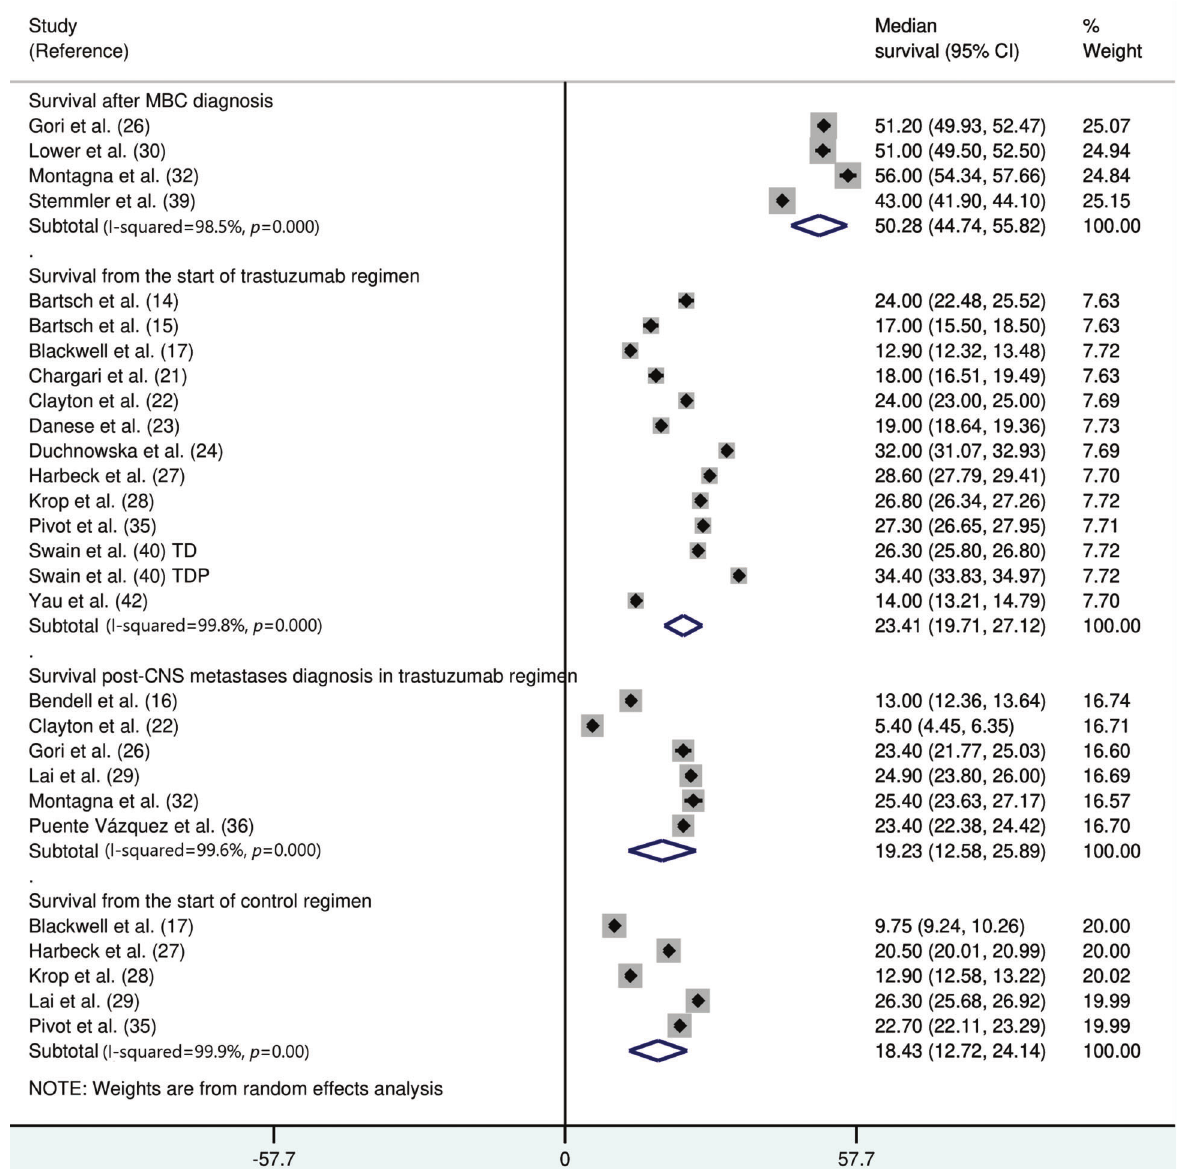
Figure 3 - Forest graph showing the results of the meta-analysis of the median survival of patients with HER2-positive MBC treated with trastuzumab or control